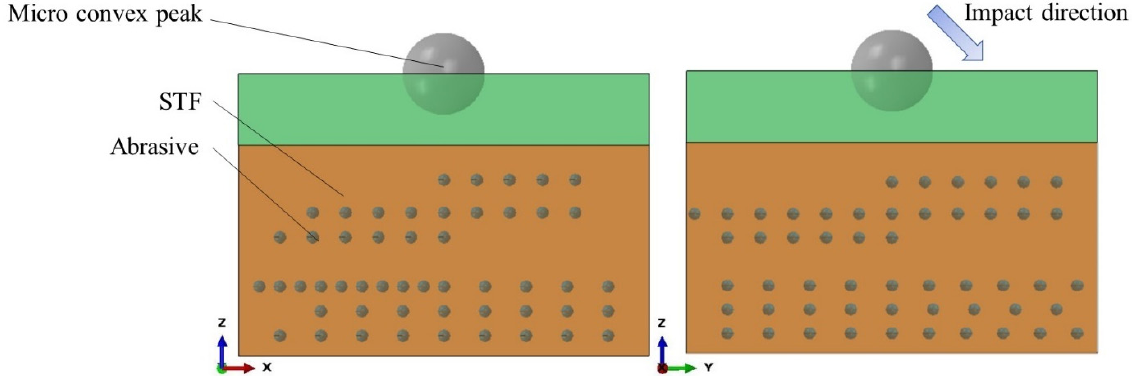
Figure 6. High-shear low-pressure flexible grinding wheel composite model.